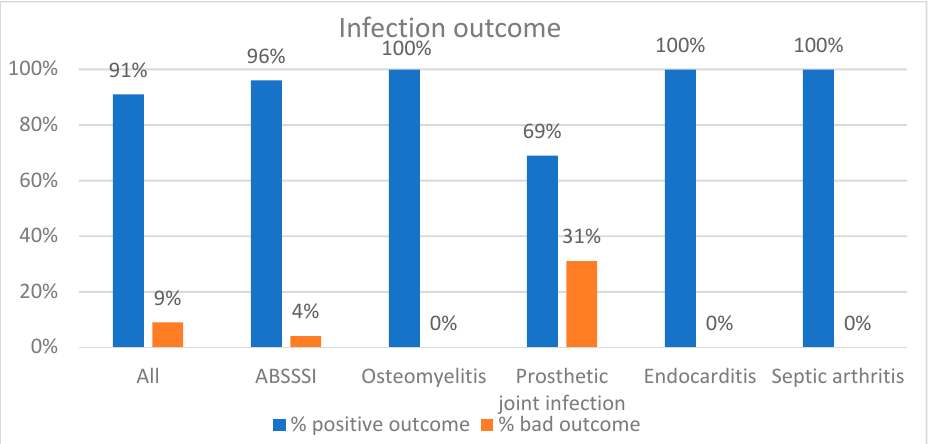
Figure 1. Clinical outcomes after dalbavancin application. The characteristics of the five patients who failed therapy are shown in Table 3. Four patients presented with a prosthetic joint infection, and three patients had concomitant Gram-negative bacterial Table 3. Characteristics of patients who failed therapy.